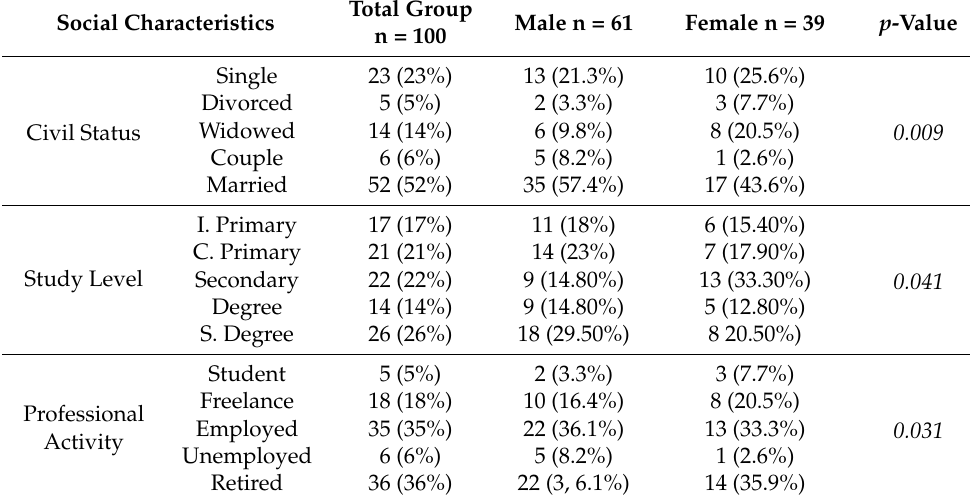
Table 2. Social characteristics of the sample by